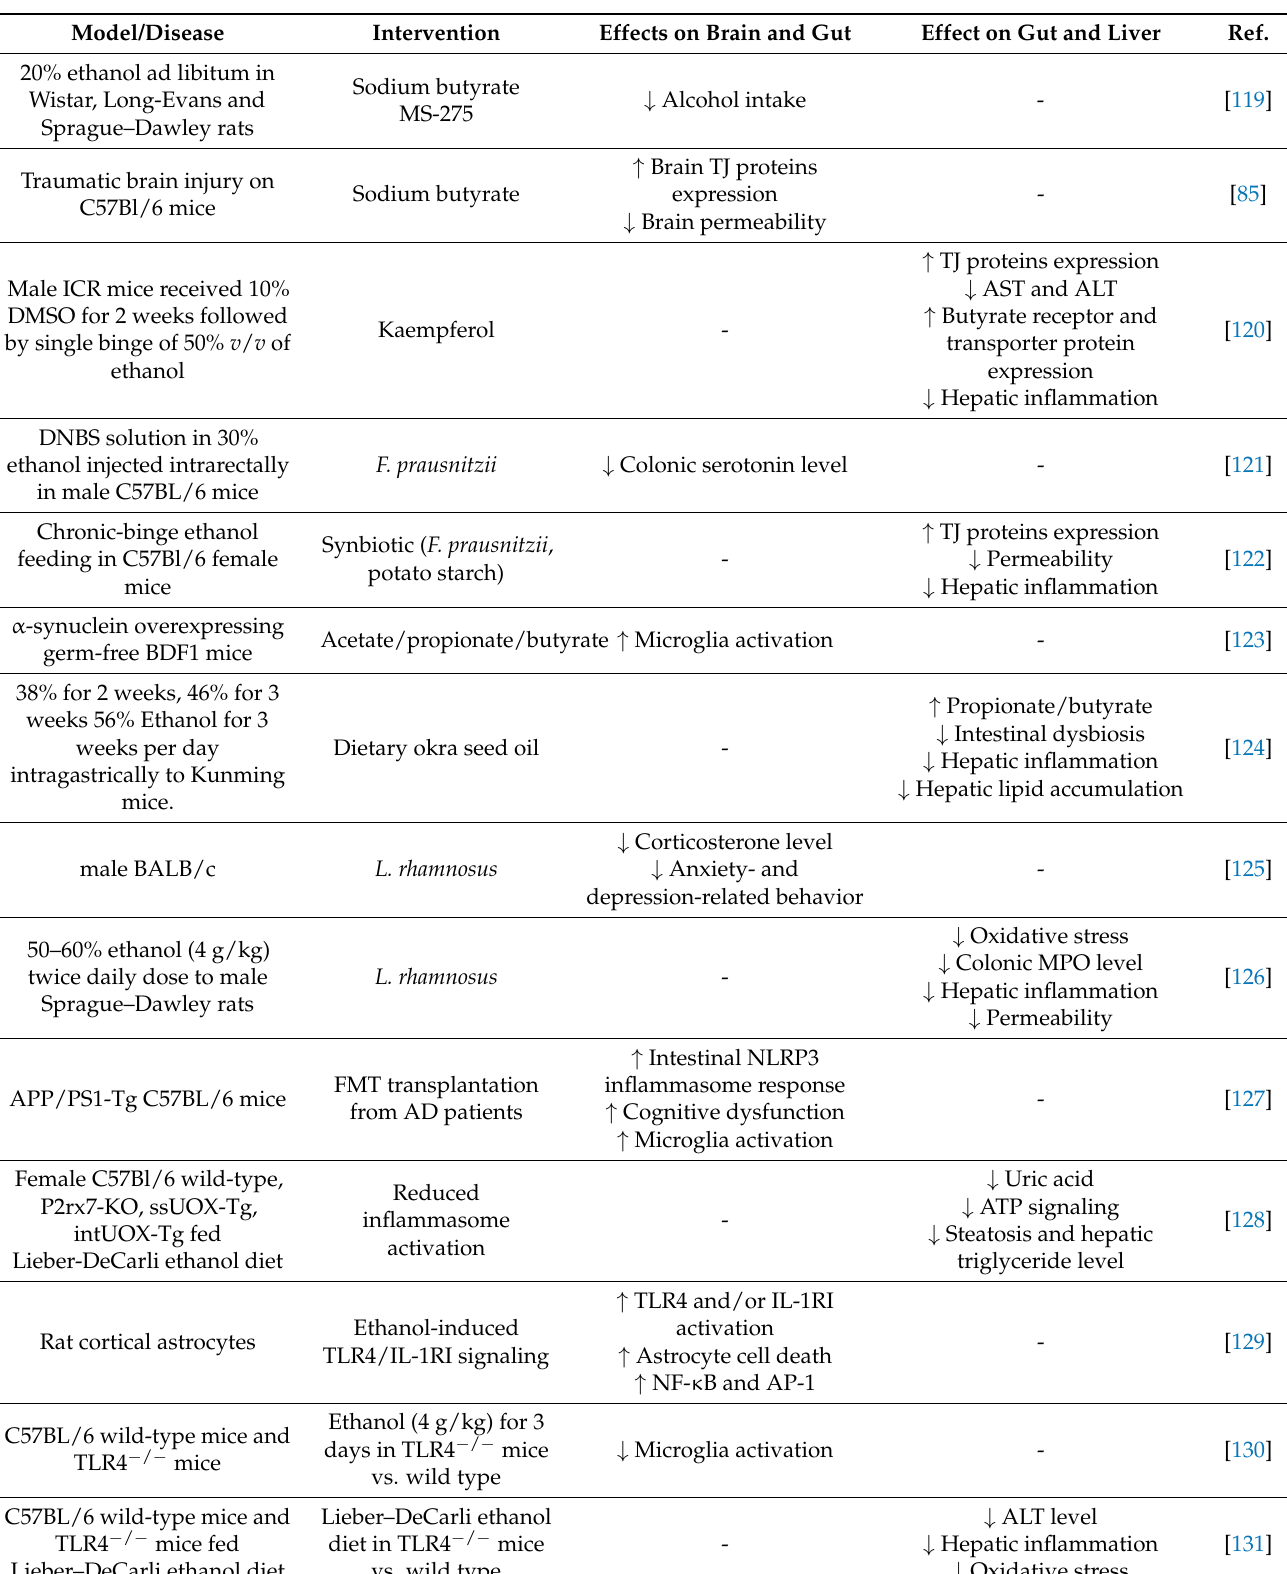
Table 1. Summary of effects of gut microbe and its metabolites implicating in brain and liver in alcohol-related animal